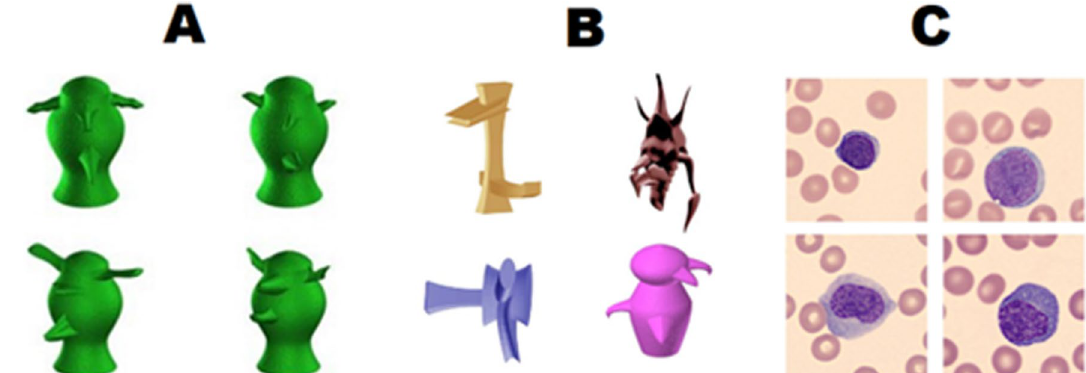
Fig. 1 Example Stimuli. A: Symmetrical Greebles used in the NOMT. B: Novel objects used in the Object Matching Test. From the top left, anticlockwise: vertical and horizontal Ziggerins, asymmetrical Greebles, and Sheinbugs. C: White blood cells used in the Blast